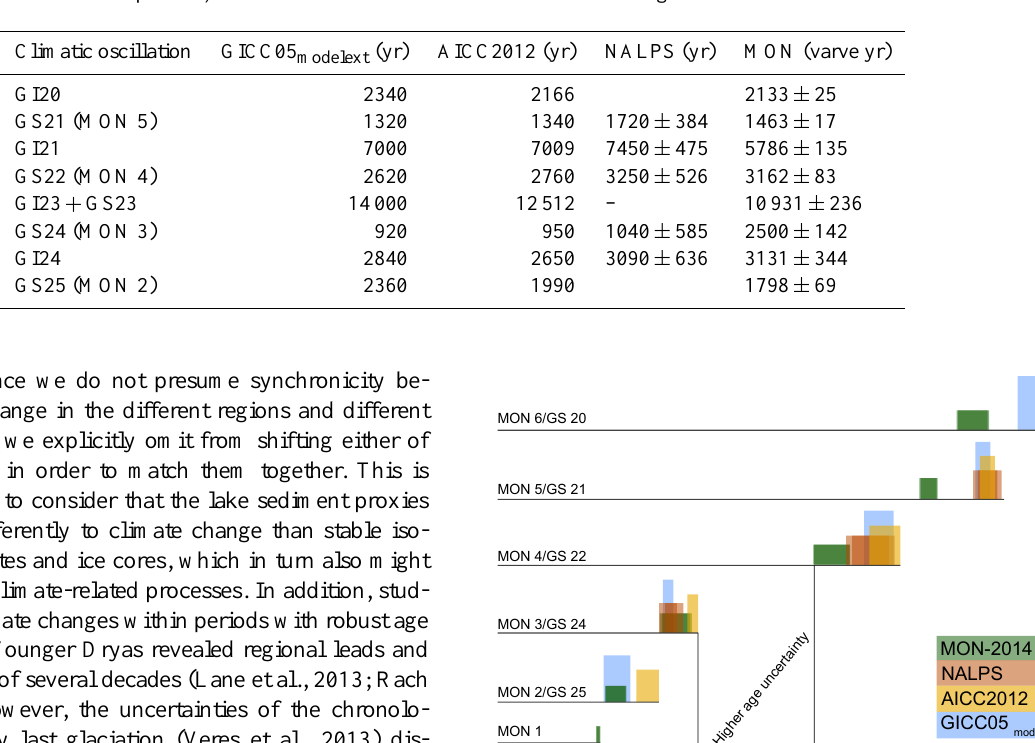
Table 2. Duration of the millennial-scale climatic oscillations (stadial and interstadials) in the four different independent chronologies from Greenland to the Mediterranean. NorthGRIP δ 18 O ice as constrained on GICC05 modelext chronology (Wolff et al., 2010) and AICC2012 timescale (Veres et al., 2013); NALPS composite speleothem δ 18 O record (Boch et al., 2011); and MON varve thickness record (this study). The gradual transition from GI23 to GS23 in the NorthNGRIP δ 18 O ice (rather than the usual sharp decrease) makes it difficult to define a clear boundary between these two periods, so the durations of GI 23 and GS 23 are shown together.